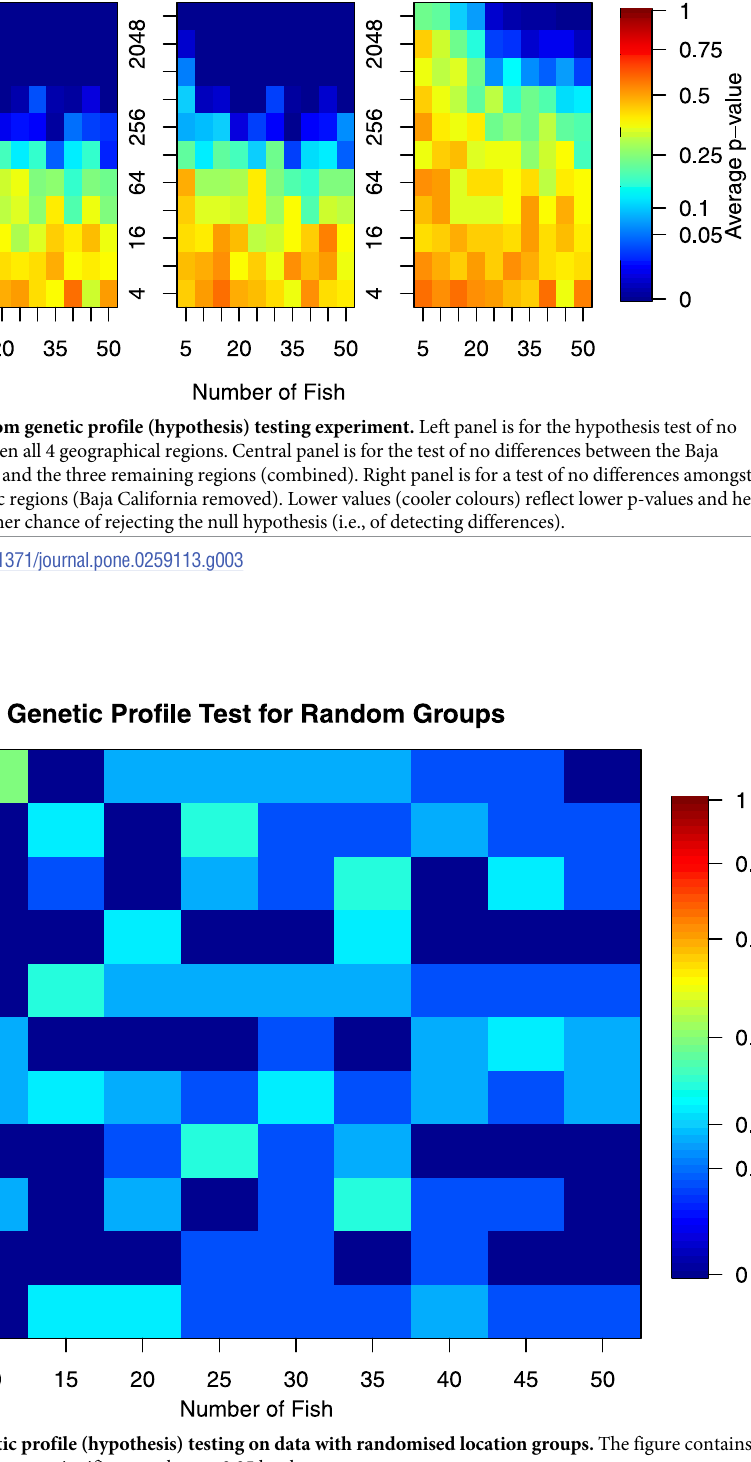
PLOS ONE | https://doi.org/10.1371/journal.pone.0259113 November4,